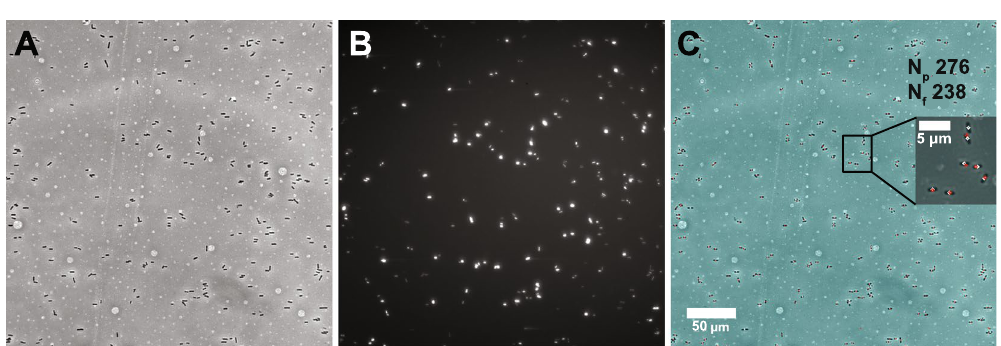
Figure 6. Sample image analysis of GEN-susceptible E. cloacae . ( A ) Raw phase contrast image at t = 120 min. ( B ) Corresponding raw fluorescence image at t = 120 min. ( C ) Composite image showing the identified bacteria in the phase contrast (white marks) and fluorescence (red marks) images. N F : number of fluorescing cells; N P : total number of